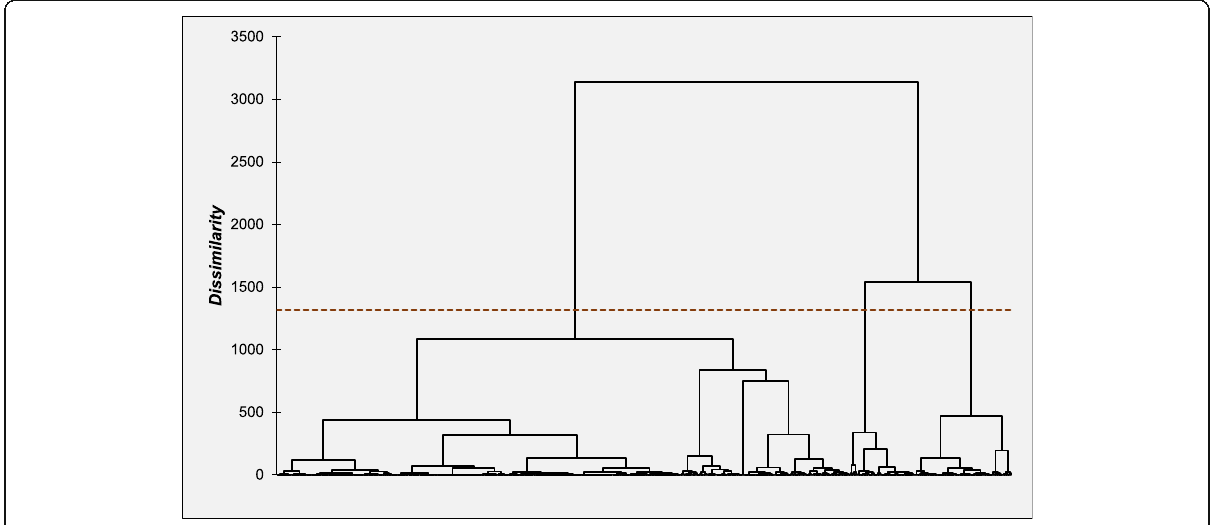
Fig. 4 Dendrogram displaying optimal solution of clustering analysis using Ward ’ s method. Left = type 1; middle = type 2; right = type